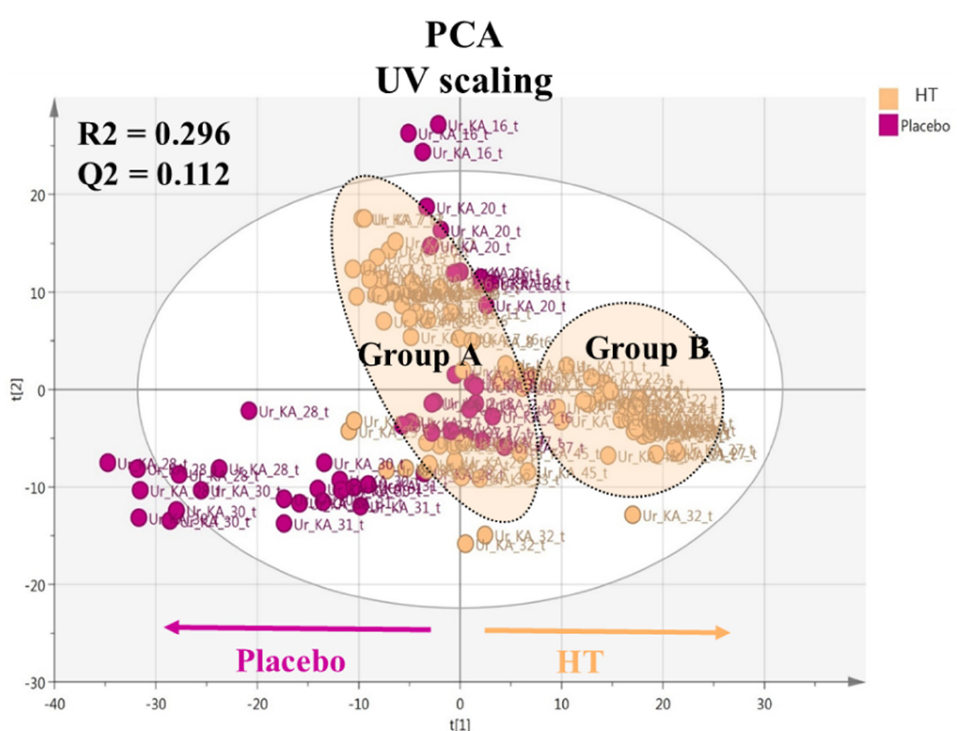
Figure 2. Principal component analysis (PCA) scores plot with unit variance (UV) scaling including the total number of samples. Observations (samples) are colored according to the administered capsule: purple for placebo and light pink for hydroxytyrosol (HT) capsules. Fitting parameters are also